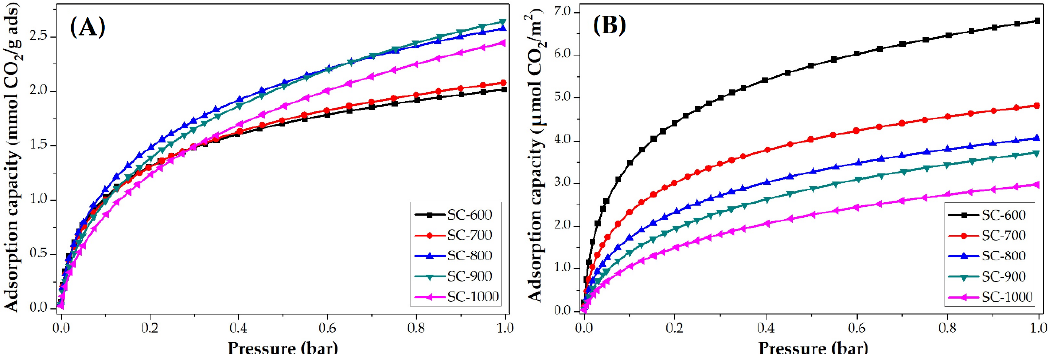
Figure 7. CO 2 adsorption isotherms at 25 °C of PANMF stabilized at 280 °C and carbonized: ( A ) mmol CO 2 /g adsorbent and ( B ) µmol CO 2 /m 2 .